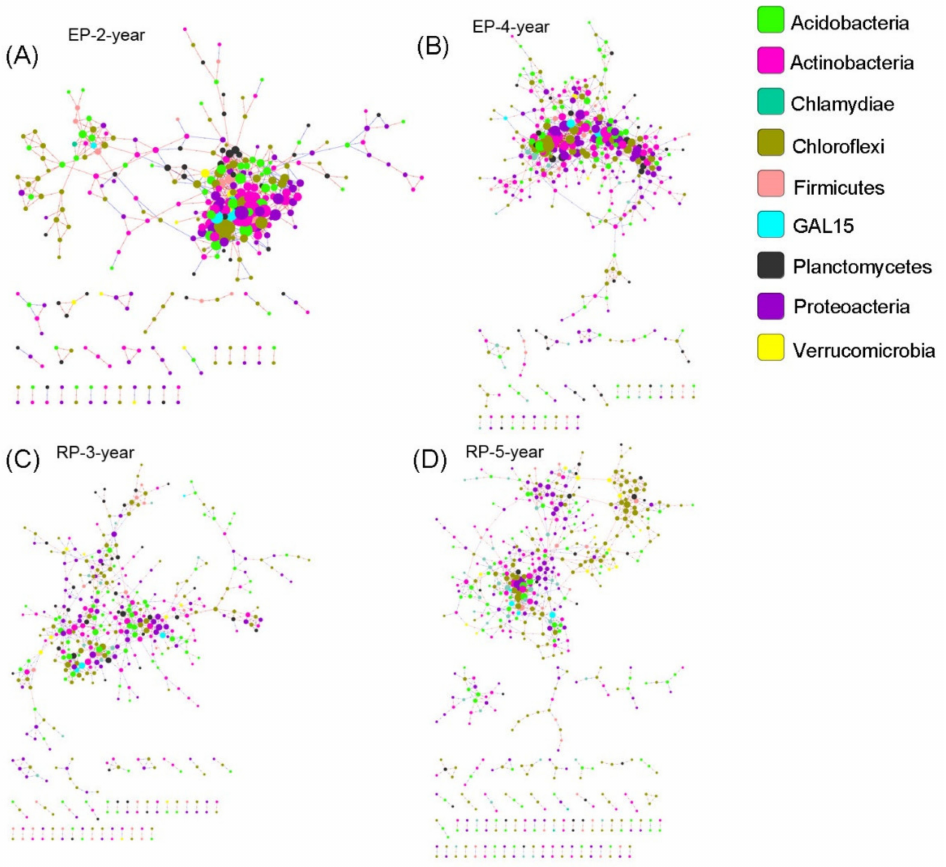
Figure 6. Soil bacterial species co-occurrence networks in the studied plantations. ( A , B ) Structure of the networks in 2-year-old and 4-year-old Eucalypt plantations (EP-2-year and EP-4-year). ( C , D ) Structure of the networks in 3-year-old and 5-year-old Rubber plantations (RP-3-year and RP-5-year). The taxonomic a ffi liation of each operational taxonomic unit (OTU) is specified to phylum, using node color, and the node size is proportional to its connectivity. The blue lines between each two-node structure indicate positive interactions, while blue ones indicate negative